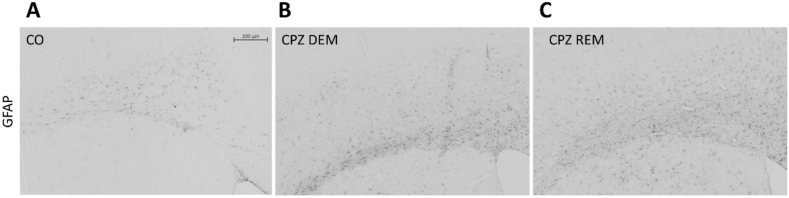
GFAP immunostaining in the corpus callosum of the CO- (A), DEM- (B) and REM (C) group. In the CO group (A) only a few astrocytes were present in the CC. During CPZ treatment an extensive astrogliosis was observed in the CPZ group (B), which persisted during remyelination phase (C). Scale bar: 200 μm. CO control group, CPZ cuprizone, DEM demyelination group, GFAP glial fibrillary acidic protein, REM remyelination group.